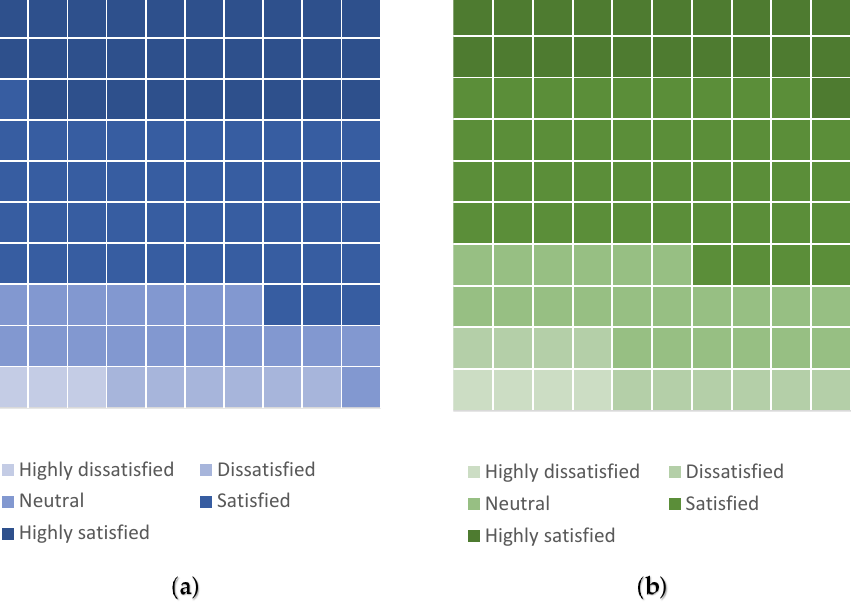
Figure 3. The overall satisfaction of PV users with car service ( a ) and with PT service ( b ) on 1–5 Likert scale.